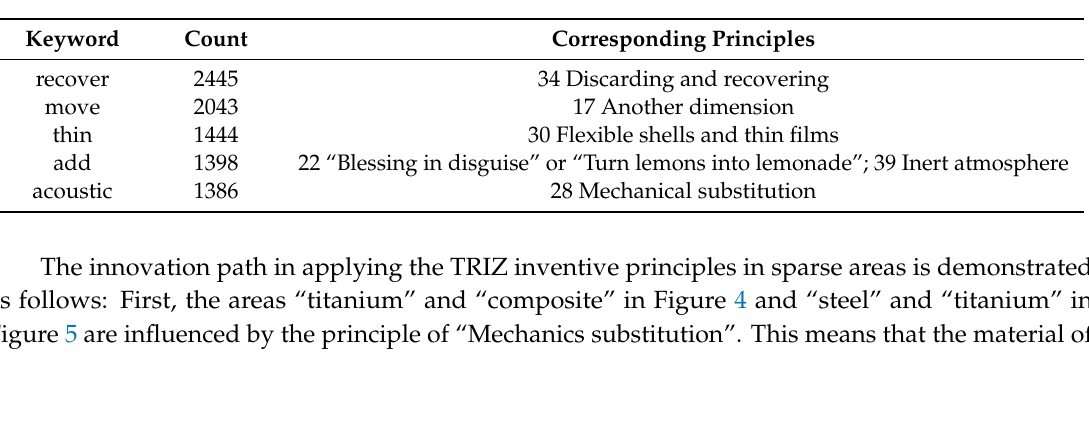
Table 10. The relevant theory of inventive problem solving (TRIZ) innovative principles in the field of underwater